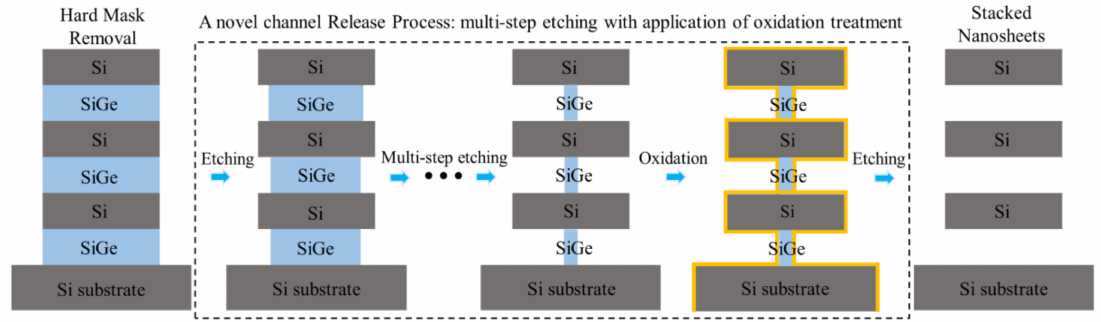
Figure 5. Schematic diagram of the multi-step etching process for the channel release of single-width nanosheets with the application of oxidation treatment.